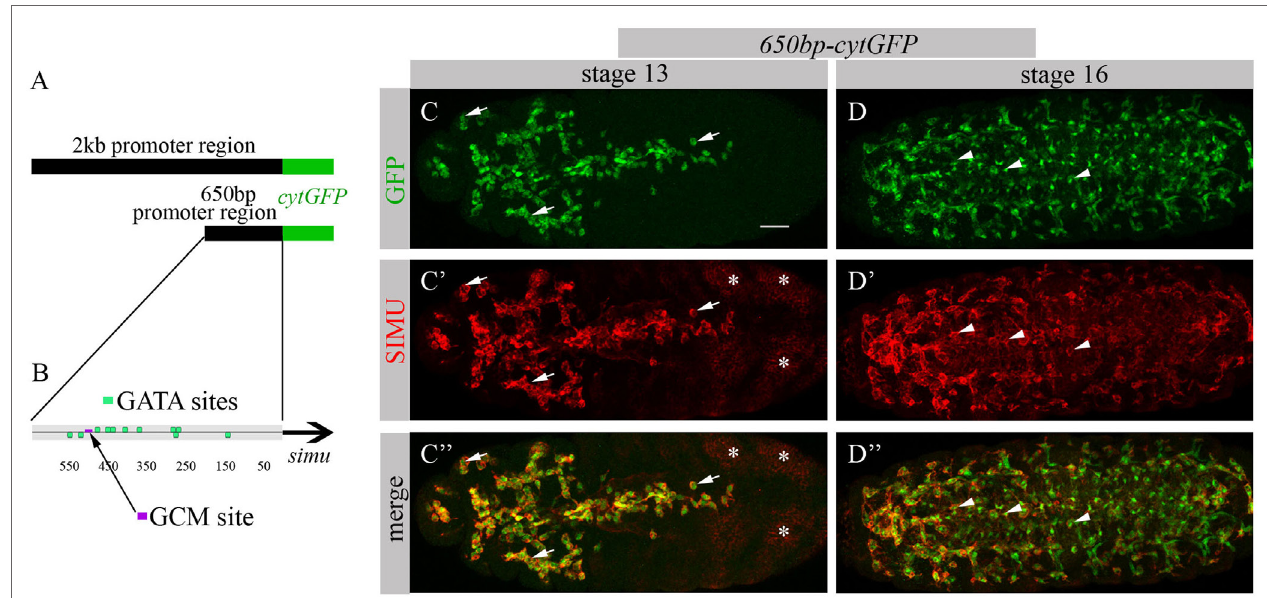
FigUre 1 | 650 bp region upstream to simu ORF recapitulates simu endogenous embryonic expression and contains multiple GATA binding sites. (a) Schematic of 2 kb region of simu promoter fused to cytoplasmic GFP sequence. (B) Schematic map of 650 bp region of simu promoter fused to cytoplasmic GFP sequence with depicted putative GATA sites and one GCM binding site. (c–D’’) Projections from confocal stacks of the stage 13 (c-c’’) and stage 16 (D–D’’) embryos, ventral view. (c,c’’,D,D’’) Cytoplasmic GFP reporter and (c’,c’’,D’,D’’) SIMU protein as detected on membranes with anti-SIMU antibody. Bar, 20 µm. Note colocalization of GFP and SIMU in macrophages (arrows) and glia (arrowheads) but not in ectoderm (stars).